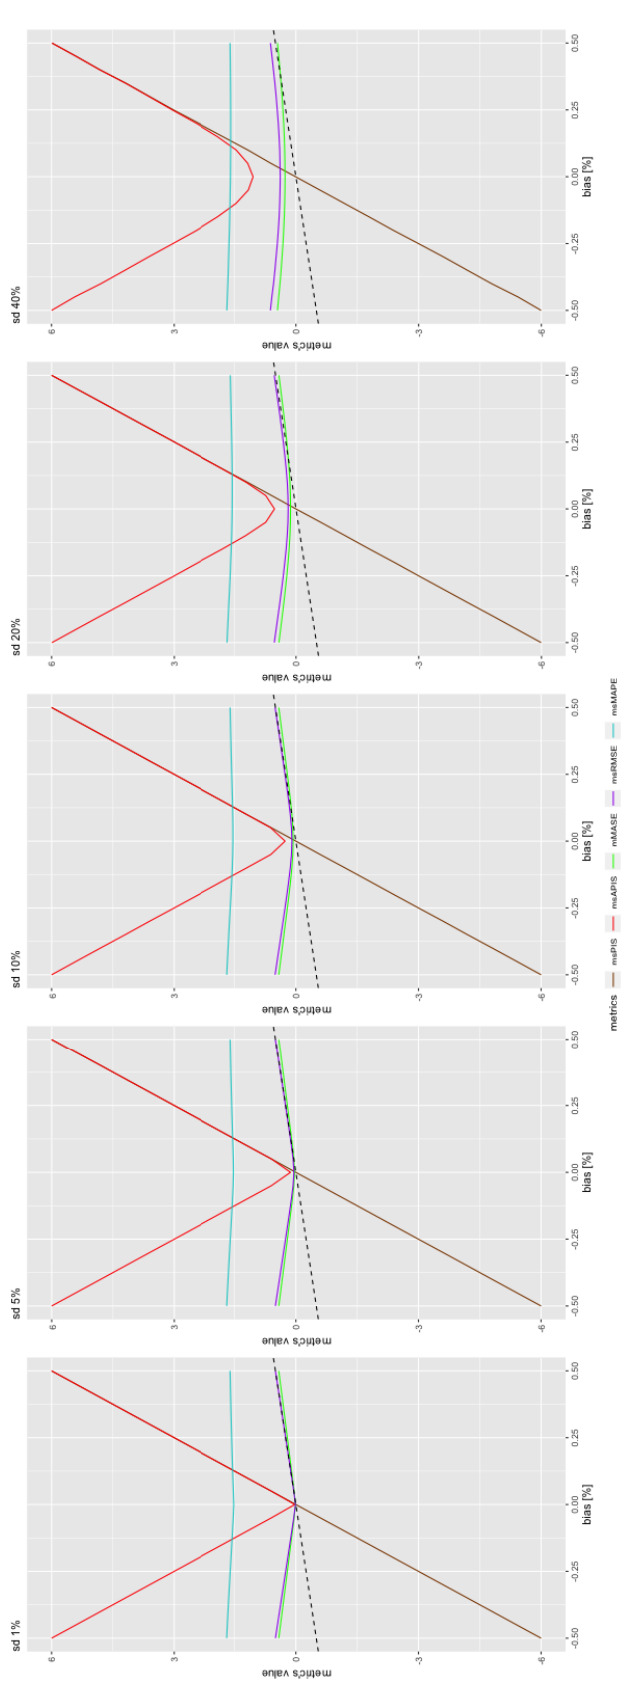
Figure 7. Impact of change in standard deviation on the different performance